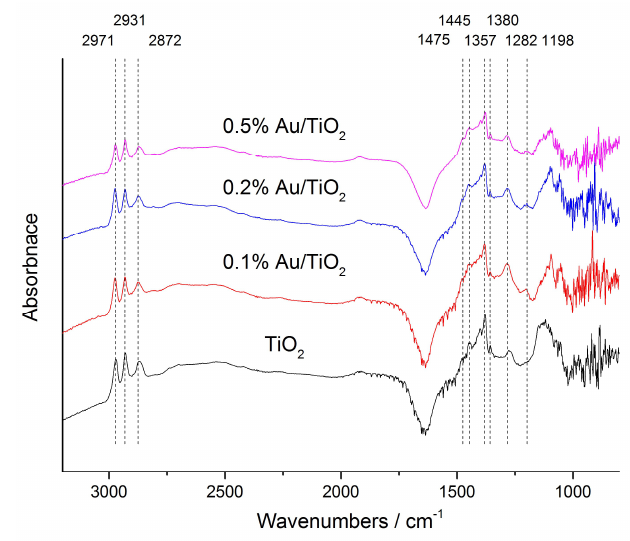
Figure 5. DRIFTS spectra recorded as a TiO 2 –supported gold sample was sequentially treated in flowing mixtures of ethanol and N 2